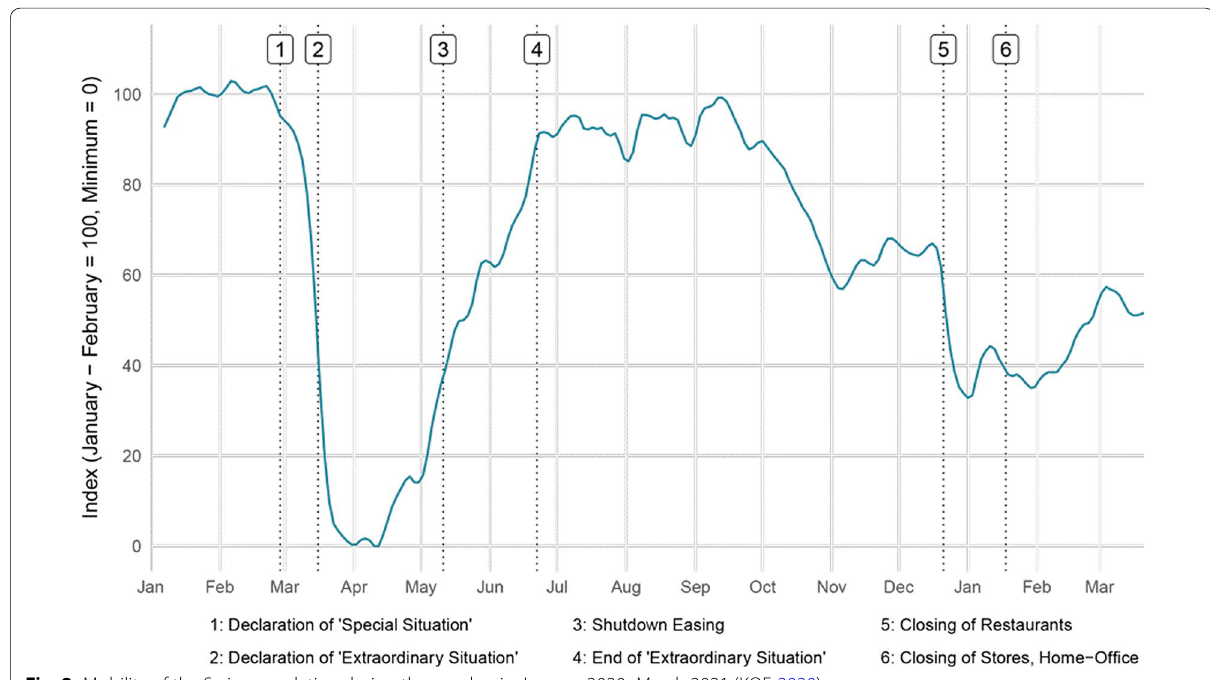
Fig. 2 Mobility of the Swiss population during the pandemic, January 2020–March 2021 (KOF,